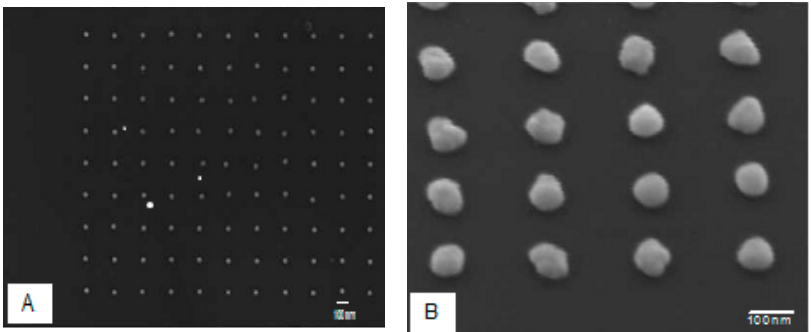
Figure 1. SEM images of nanoparticles obtained with ( A ) electron beam lithography (EBL) method. The nanoparticles are perfectly aligned within a well-defined array ( B ) and are not perfectly spherical or